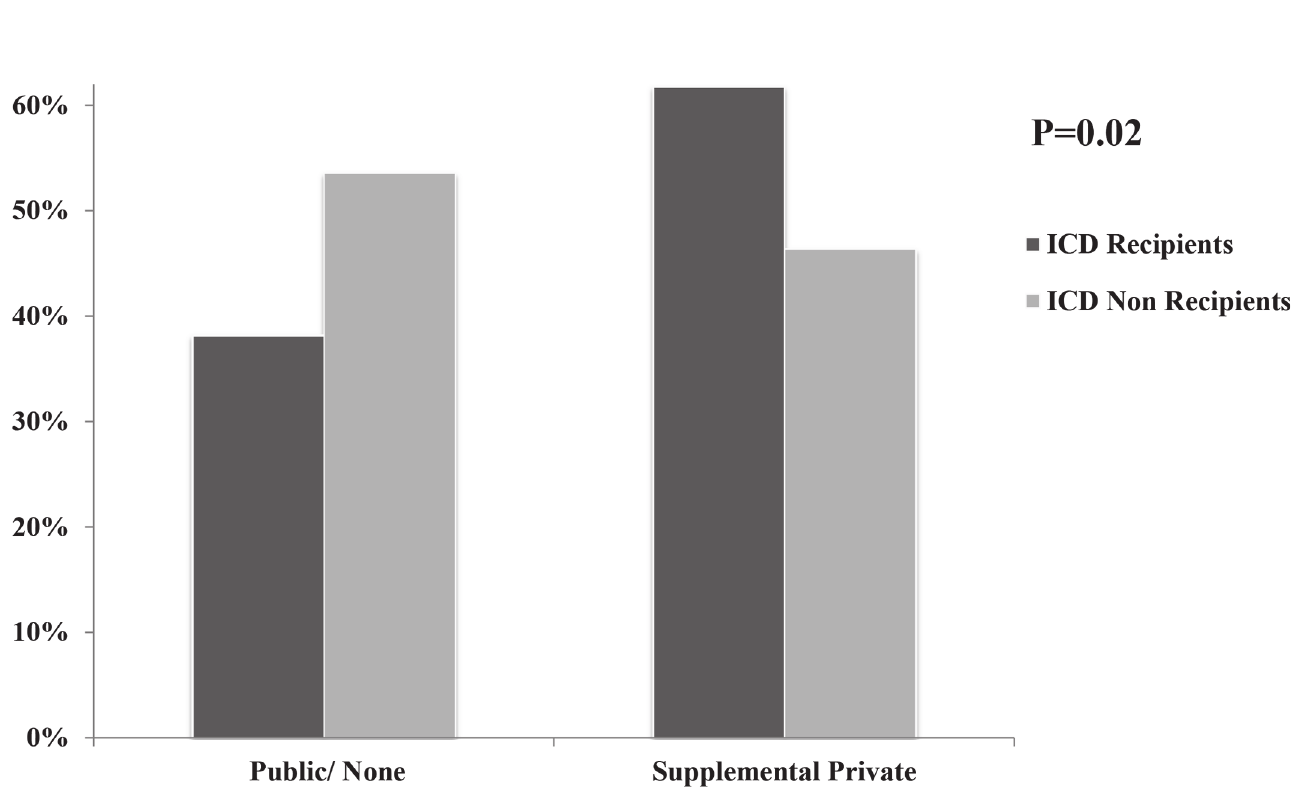
Fig 2. Health Insurance Status of ICD Recipients versus